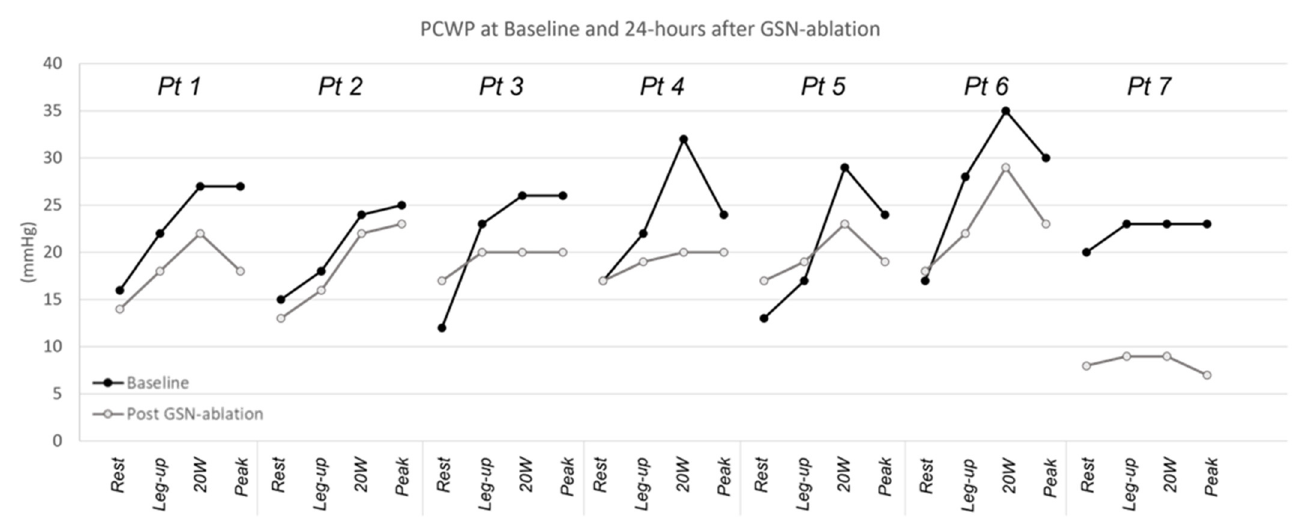
Figure 1. Resting and exercise pulmonary capillary wedge pressure. Abbreviations: GSN, greater splanchnic nerve; PCWP, pulmonary capillary wedge pressure.